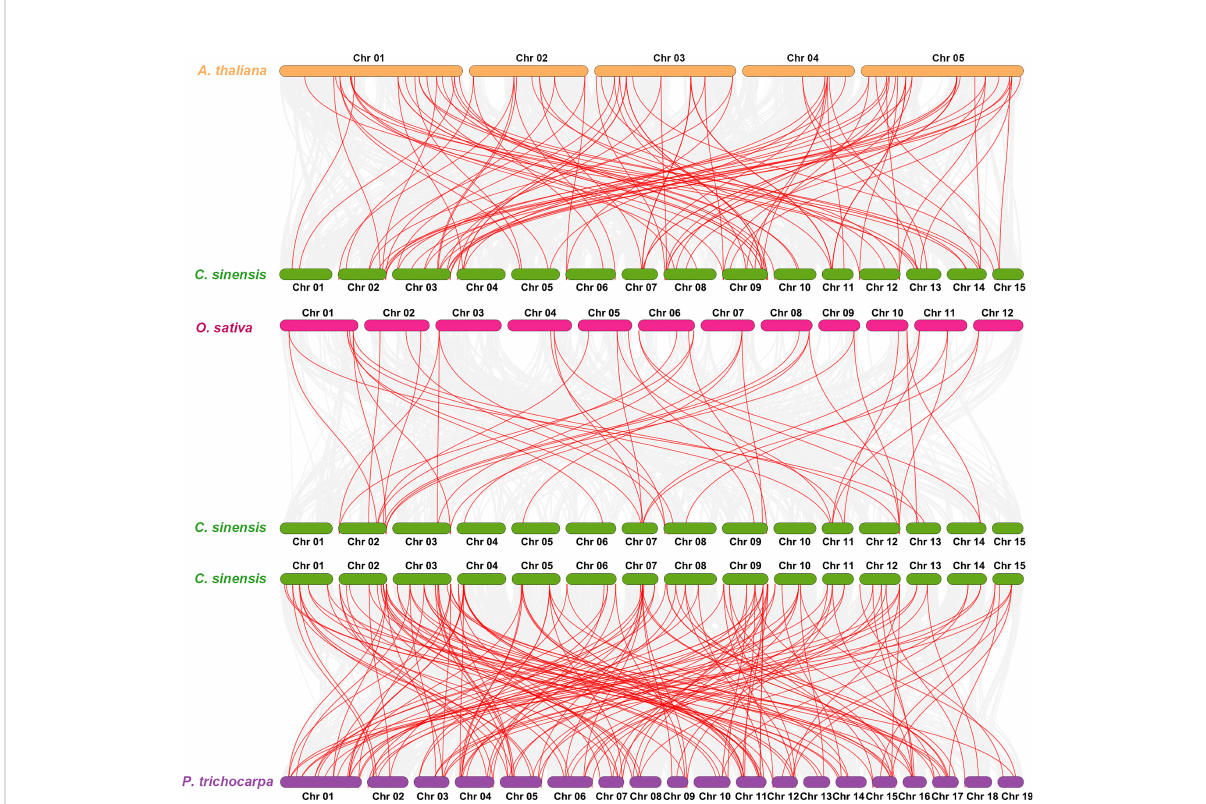
FIGURE 3 Synteny analysis of NAC genes between C. sinensis and three representative species. Red lines highlight the syntenic NAC gene pairs with the Camellia sinensis and other plant genomes, whereas gray lines in the background indicate the collinear